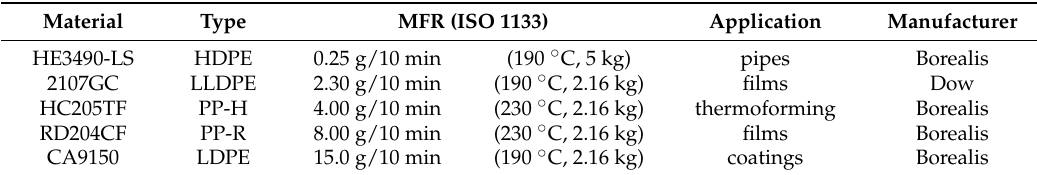
Table 2. Comparison of the materials tested (MFR—melt flow rate, HDPE—high density